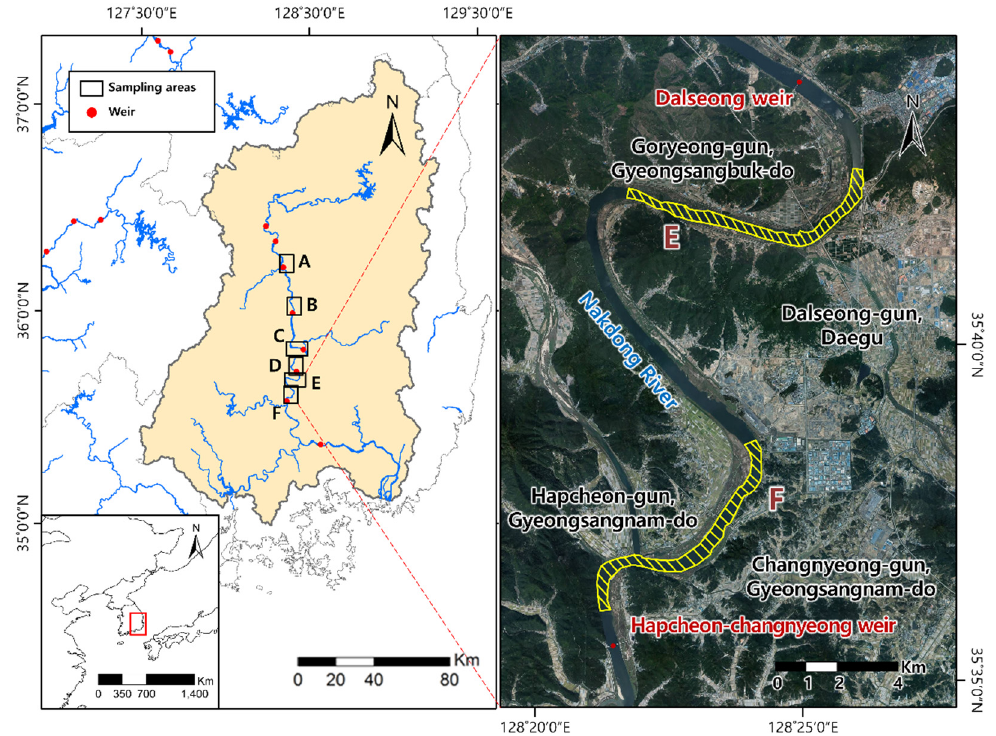
Figure 1. River sections (marked as rectangles) representing the sampling zones along the Nakdong River ( left ). An enlarged image of zones E and F is presented ( right ).